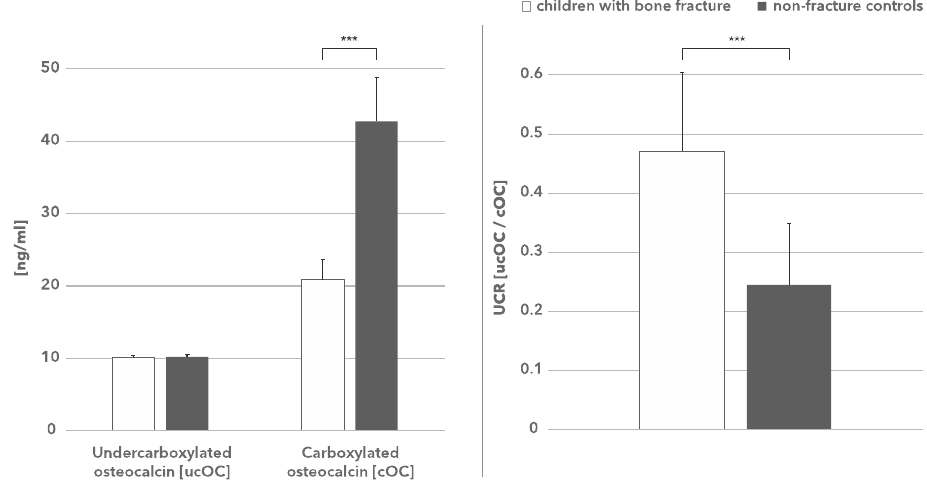
Figure 1. Undercarboxylated and carboxylated osteocalcin in children with bone fracture and non-fracture controls. The carboxylated osteocalcin is significantly (*** p < 0.0001) decreased in children with bone fractures (left hand figure) which is reflected by a higher UCR ratio (right hand figure).